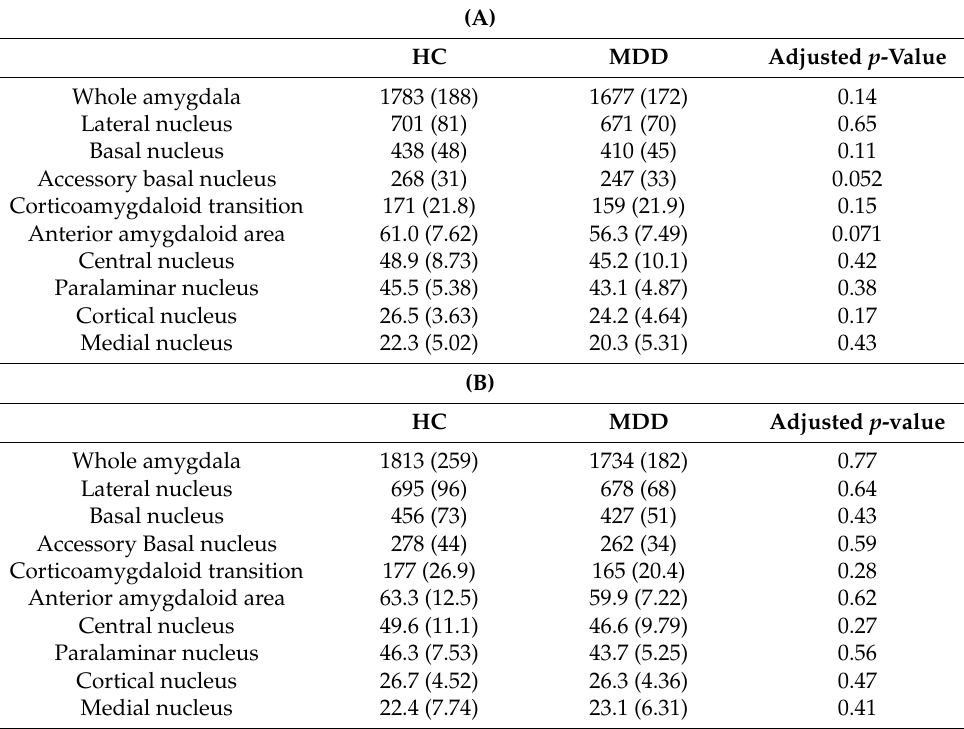
Table 3. ( A ). Left amygdala volume (mm 3 ); ( B ). Right amygdala volume (mm 3